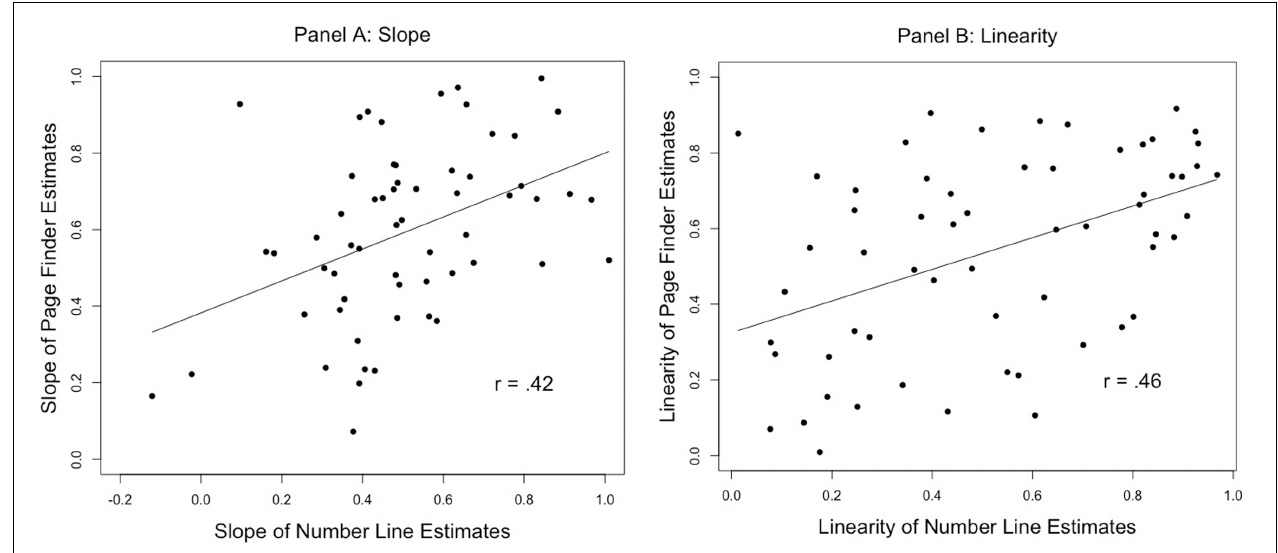
FIGURE 1 | The slope of children’s number line estimates were significantly related to the slope of children’s page finder estimates (A) . Furthermore, the linearity of children’s number line estimates were significantly related to the linearity of children’s page finder estimates (B) .